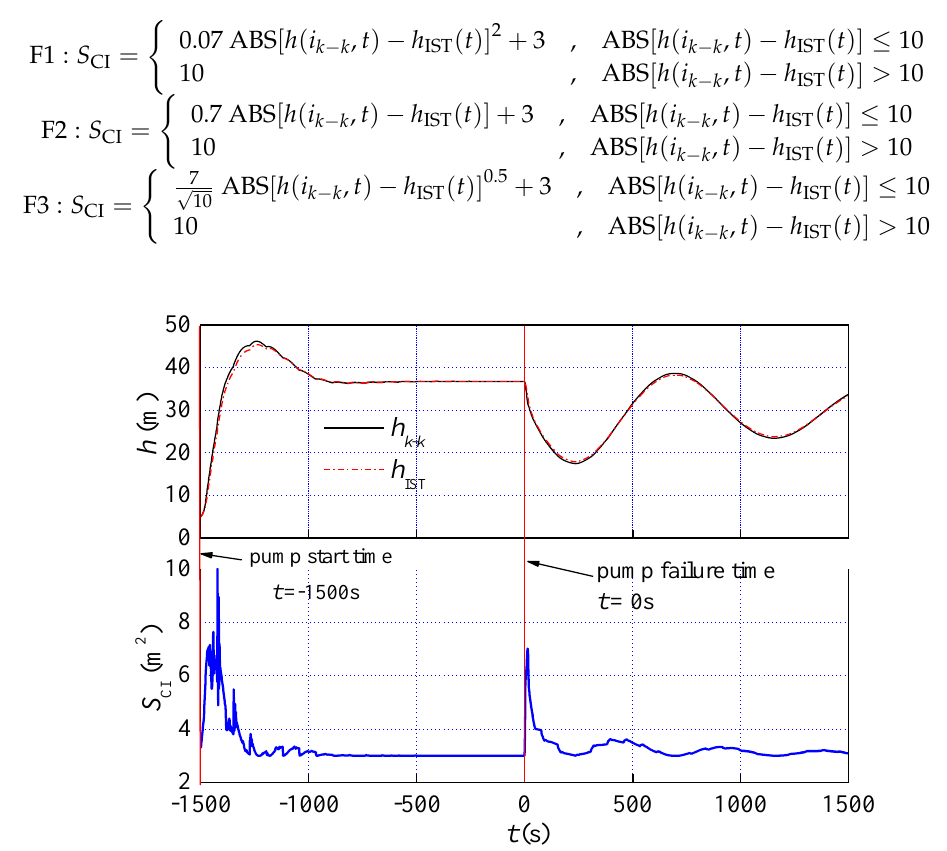
Figure 12. The transient process in the IST.